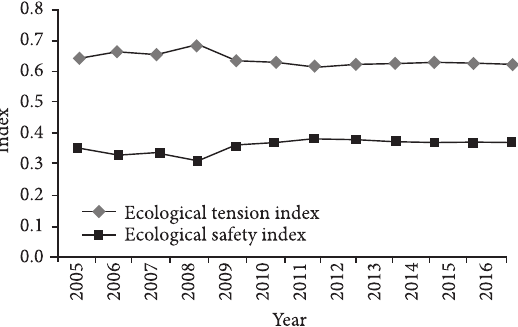
Figure 5. Variation trend of ecological tension index and Figure 6. Variation trend of ecological